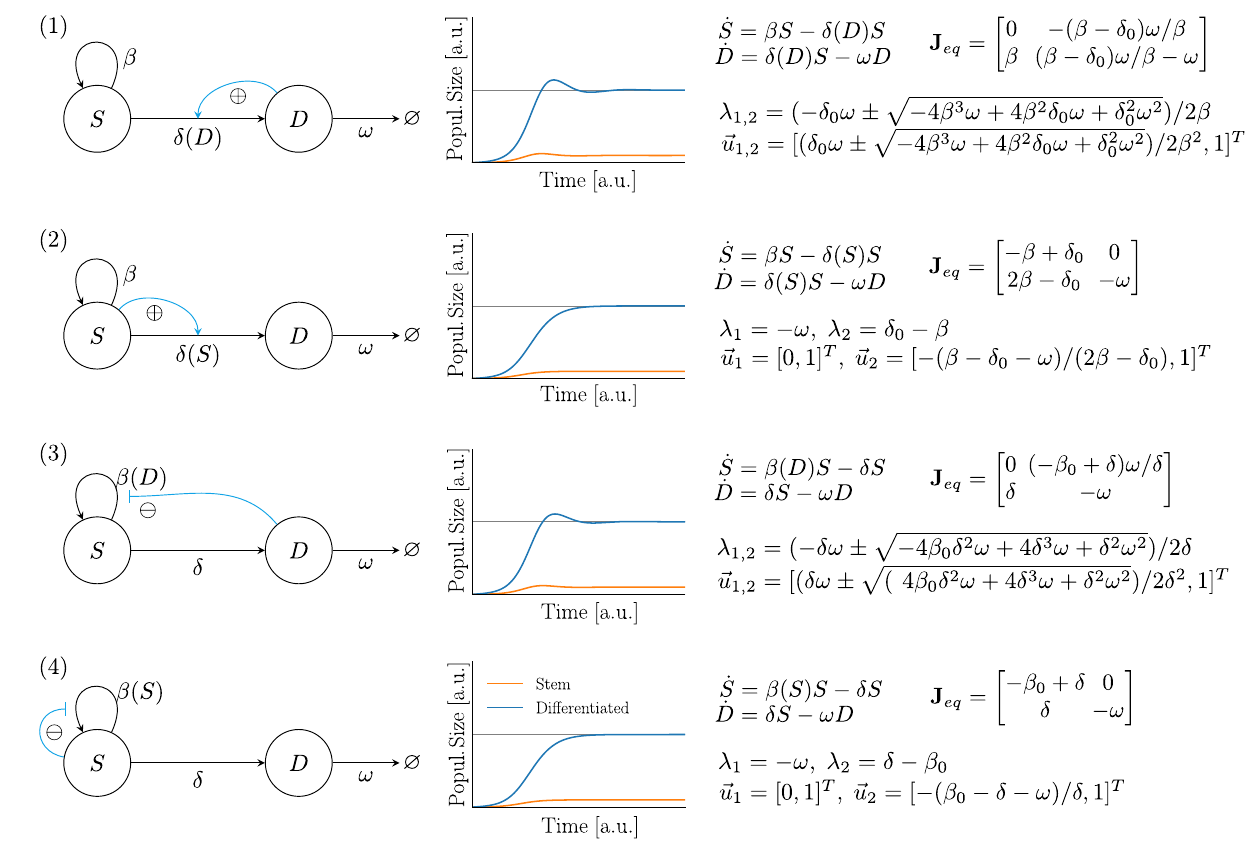
Figure 2. All four one-looped model topologies that can show homeostasis. First column: schematic sketches; second column: exemplary numerical simulations; third column: model equations, as well as Jacobian at the non-trivial steady state and its eigensystem for the case of a linear feedback function β( x ) = β 0 + β slope x or δ( x ) = δ 0 + δ slope x , state, as the slope is not part of the Eigensystems of the steady state Jacobians of the models. Third, the displace- ments of all models from steady state of the first and second perturbation are linear in the initial displacement ( � D ( 0 ) or � S ( 0 ) , respectively). This indicates that in both cases the choice of initial displacement (i.e. which fraction of the cell pool size we remove) will not affect the comparison between model defects, and we can express all defects as simple multiples of initial displacement. In case of the third perturbation, we remove the same fraction of stem and differentiated cells, and we express the defect as multiples of the initial displacement of dif- ferentiated cells. Overall, the complete parameter space we need to consider thus consists only of the ratio of stem to differentiated cells at steady state and two additional free parameters (depending on the model β 0 , δ or β , δ 0 ). We show the defects of all four models in Supplementary Figures S2-S5. a. Colon model vs. direct stimulation of stem cell differentiation We start by comparing our basic colon epithe- lium model (model 1), with model 2, where stem cell differentiation is stimulated by the stem cell compartment itself (Fig. 3b). Figure 3c shows the difference in model defects throughout the parameter space (see Supple- ment for the raw values), where areas shaded in red indicate regions where the colon epithelium model has a bigger defect than the alternative model. In case of removing differentiated cells (first row) or removing both differentiated and stem cells at the same time (third row), there exist ample regions (shaded in blue) where the colon model recovers more efficiently—namely, whenever δ 0 is close to β . This makes sense, because in the colon epithelium model removing differentiated cells will cause the stem cells to differentiate more slowly and thus grow in numbers quickly, thus being able to replenish the differentiated cell compartment more quickly. However, in case of removing only stem cells (second row), the colon epithelium model always performs worse than the alternative model, except for cases where the fraction of stem cells at the steady state becomes sufficiently big (middle and right column). However, even then the difference between δ 0 and β still needs to be small for the colon model to recover more efficiently. Intuitively, the inefficient recovery of the colon model to a removal of stem cells can be explained as follows: After an abrupt reduction of stem cell numbers, stem cell proliferation rate and stem cell differentiation rate are still equal, and thus the number of stem cells will stay constant first. Only after some time has passed, the number of differentiated cells will have significantly decreased (due to the reduced influx of new cells). Only then, the stem cell differentiation rate decreases, and the stem cell compartment can start to expand again. For the same reason, the colon model recovers efficiently from a removal of differentiated cells: an abrupt reduction of the number of differentiated cells will lead to an instant, stepwise reduction of the stem cell